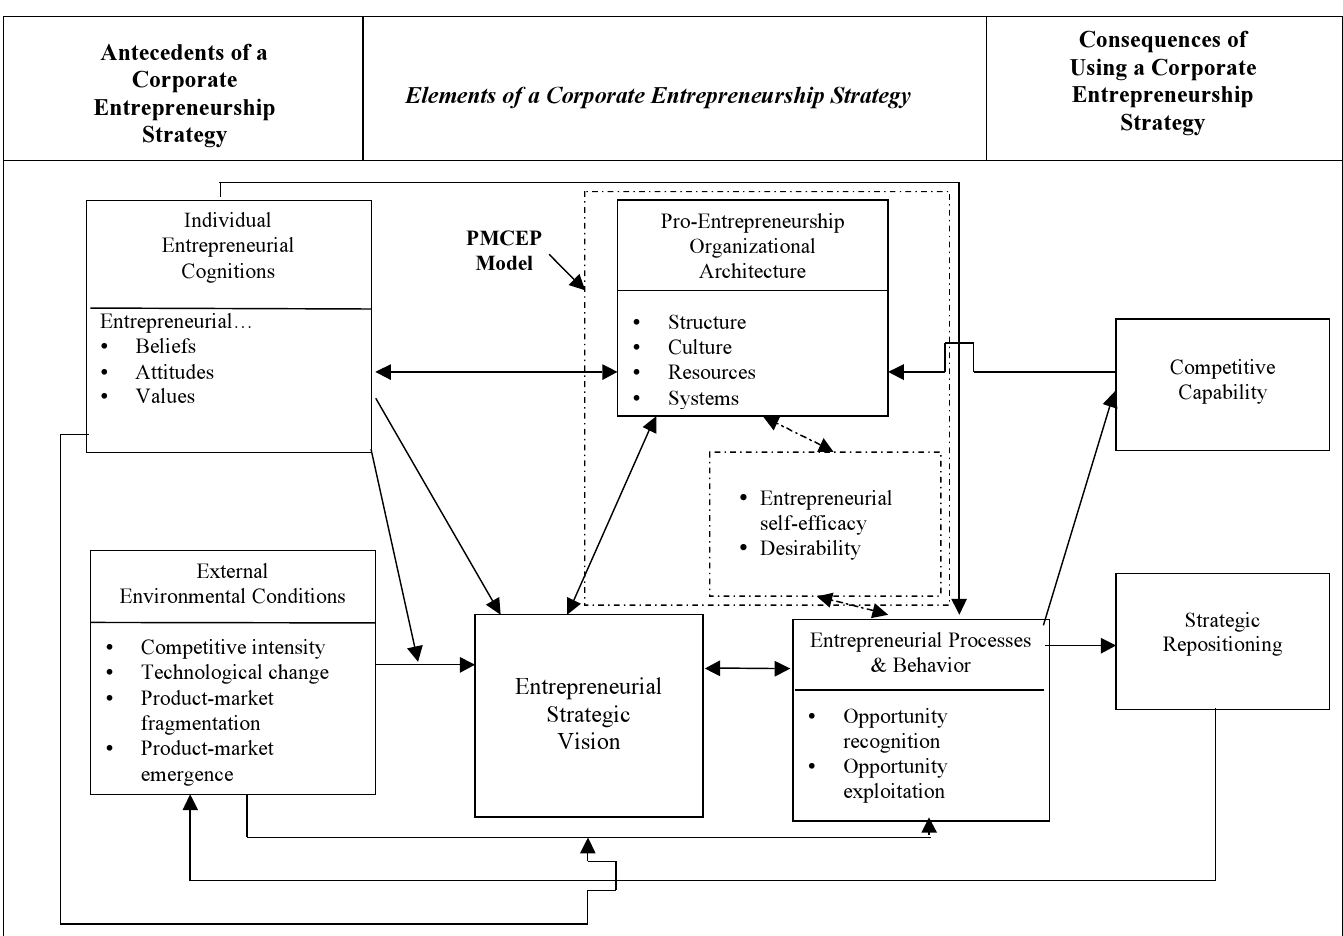
Figure 2. A Model of Corporate Entrepreneurship Strategy (Ireland, Covin, and Kuratko